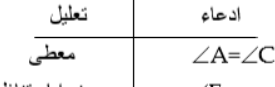
Figure 12. One of the conditions is missing.